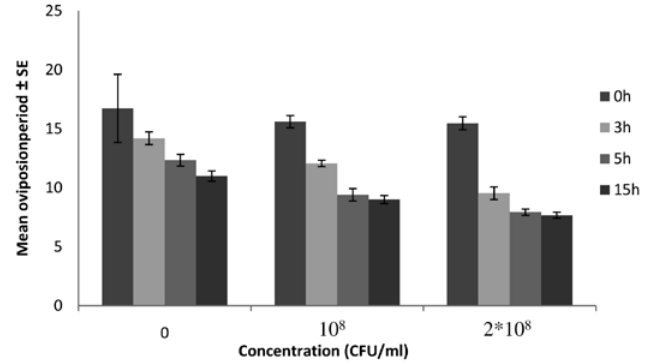
Fig. 4 - Effect of root soaking duration in bacterial suspension on mean oviposition period of